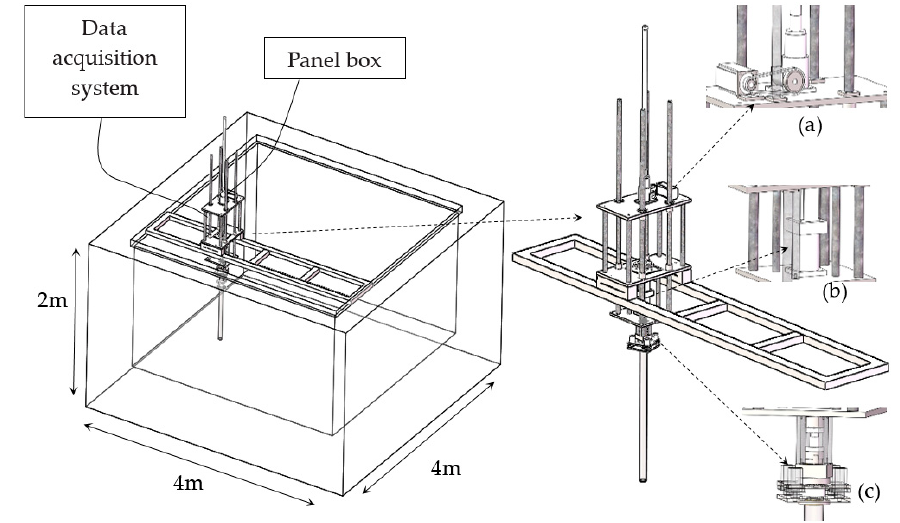
Figure 5. Sand tank and testing apparatus: ( a ) servo motor which controls vertical speed of model piles; ( b ) servo motor which controls rotational speed of model piles; ( c ) the monitoring part.